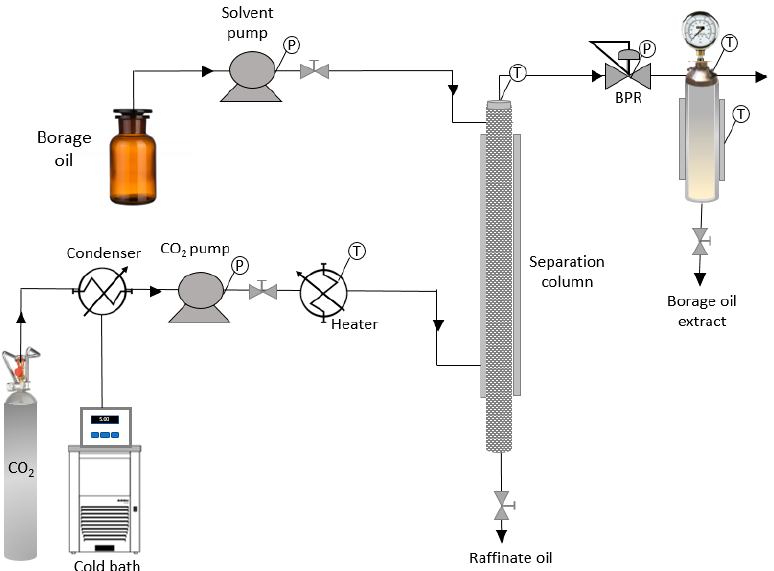
Figure 2. Simplified diagram of the countercurrent supercritical fluid fractionation column (BPR: automated back pressure regulator, S1 and S2: cyclonic separators, T: temperature, P: pressure).